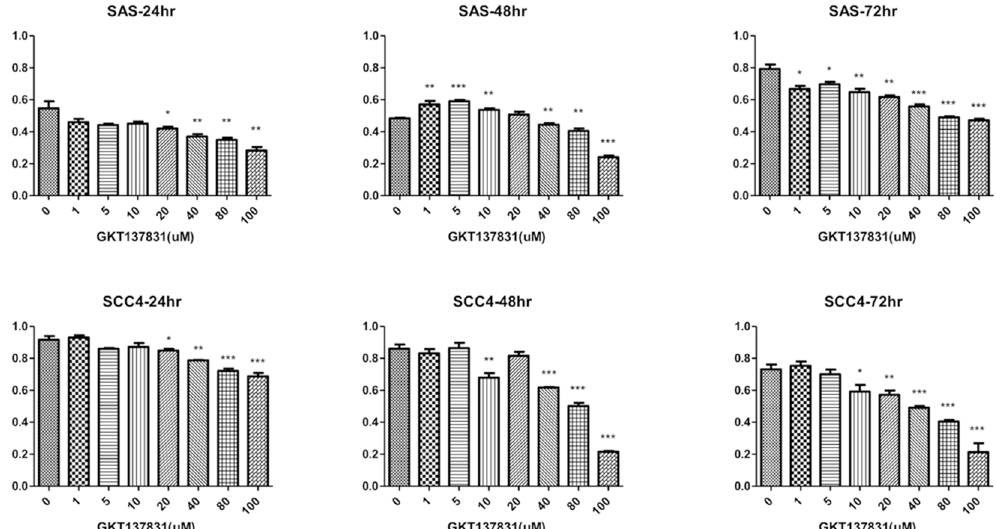
Figure 2. Nox4 inhibitor (GKT-137831) displays a growth inhibitory effect in a dose-dependent manner in the two oral tongue squamous cell carcinoma cell lines, SAS and SCC4. Columns, mean; bars, standard deviation. Significant difference in growth inhibition: * p < 0.05, ** p < 0.01 and *** p < 0.001.